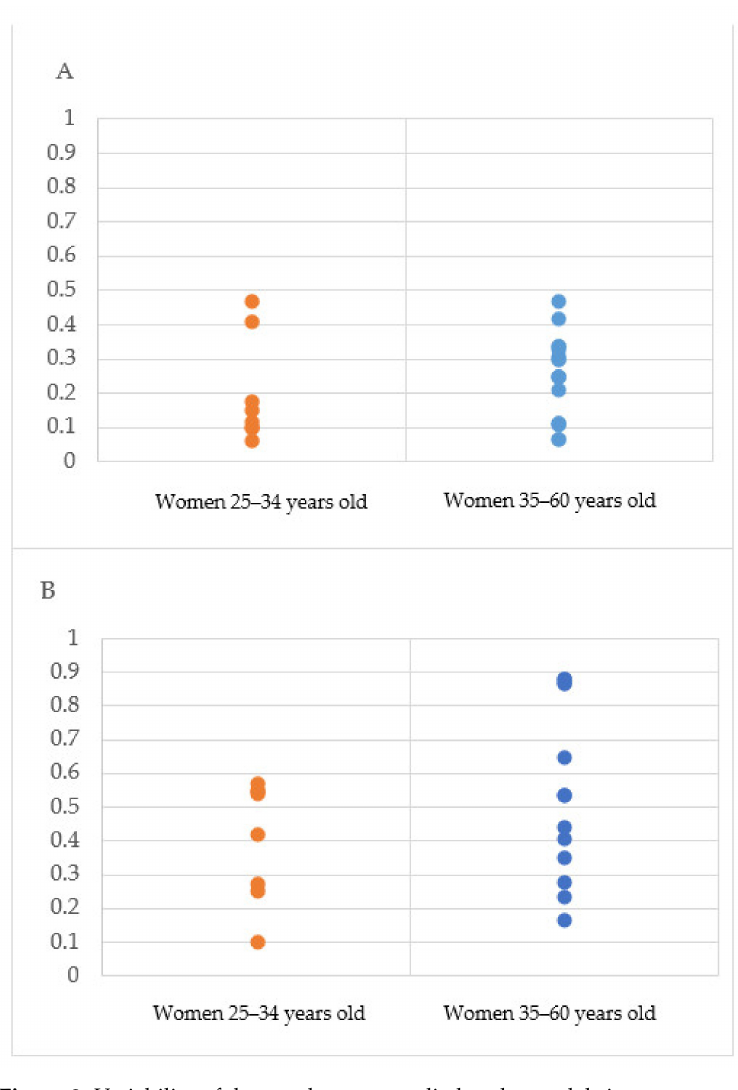
Figure 2. Variability of the uptake rates applied to the models in two age groups. ( A ) Uptake rates of risk-reducing mastectomy; ( B ) uptake rates of risk-reducing